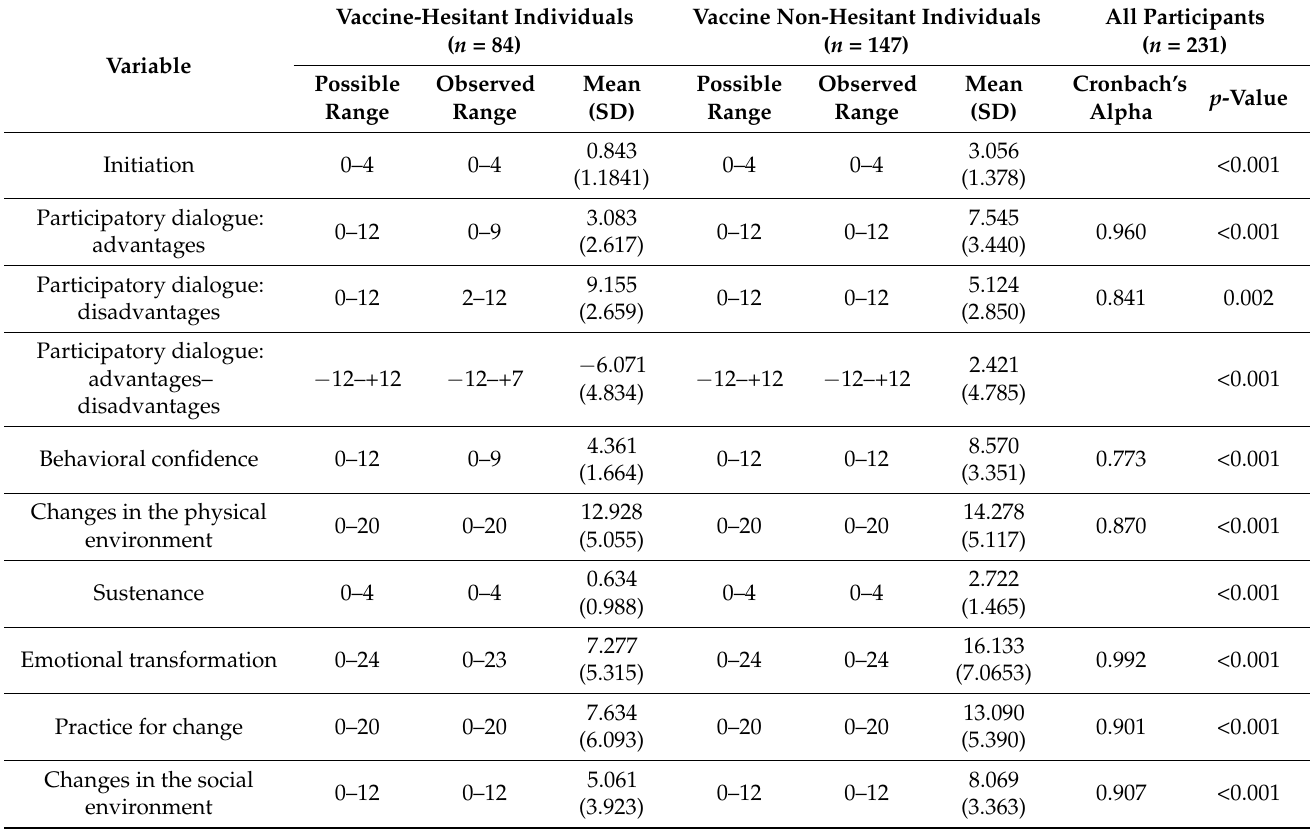
Table 2. Descriptive characteristics of study variables ( n =